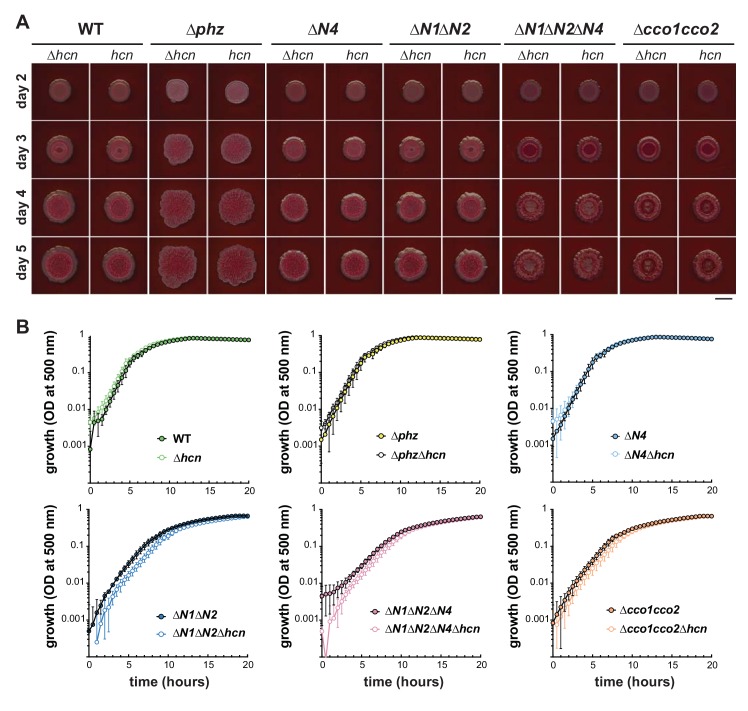
PA14 WT, ∆phz, and cco mutant growth phenotypes are unaffected by endogenous cyanide production.(A) Colony development over 4 days for ∆phz, ∆hcnABC, and cco combinatorial mutants. Images were generated using a flatbed scanner and are representative of at least 3 biological replicates. Scale bar is 1 cm. (B) Growth of ∆phz, ∆hcnABC, and cco combinatorial mutants in MOPS defined medium with 20 mM succinate. Error bars represent the standard deviation of biological triplicates and are not shown in cases where they would be obscured by the point marker.